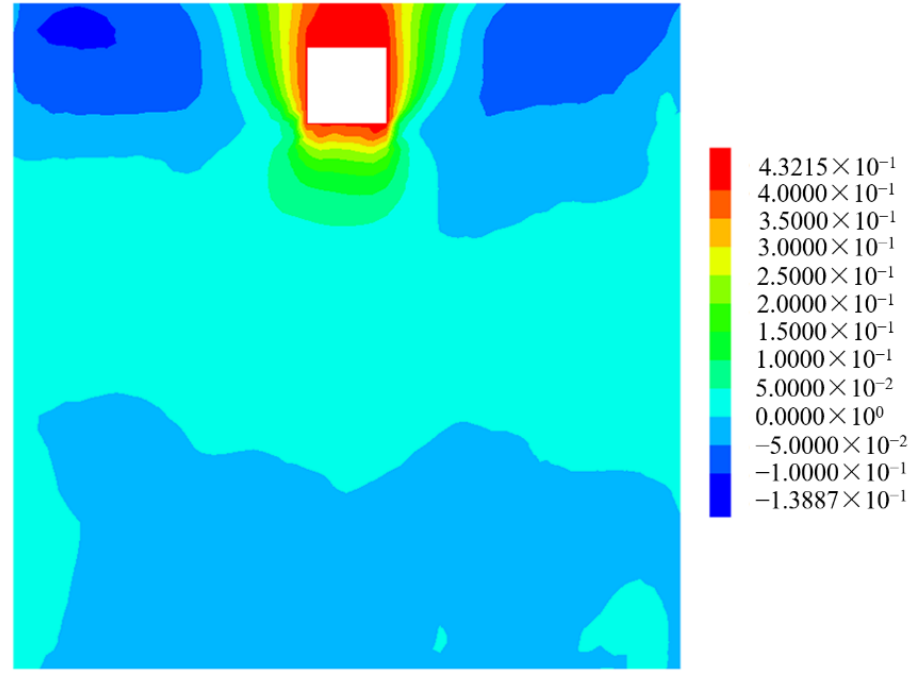
Figure 21. The contour of displacement at the embedment depth of 6 m.